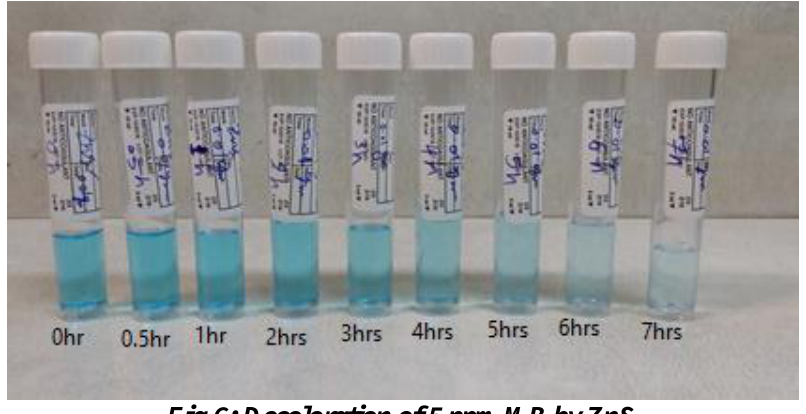
Fig.6: Decoloration of 5 ppm MB by ZnS.